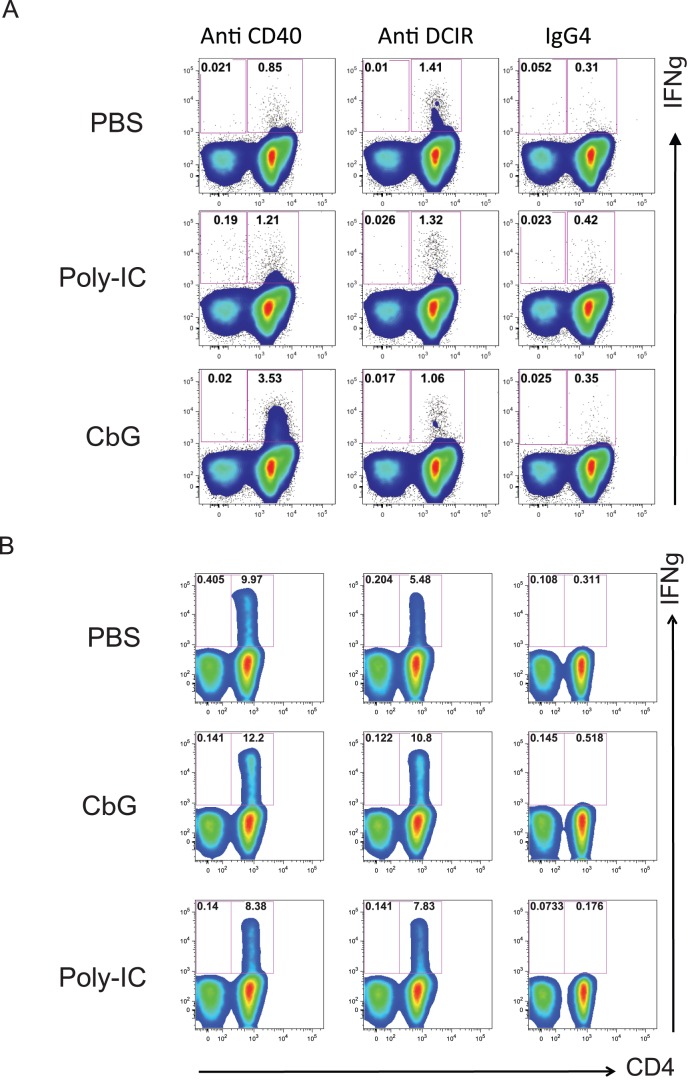

B. melitensis CβG potentiates CD4+ T memory responses in HCV and TB patients.(A) CβG induces CD3+CD4+IFNγ+ T cells after anti-CD40 HCV-NS3HelB DC-targeting of PBMC in HCV cured patients. HCV antigens from NS3 Helicase HelB construct were delivered to IFNα DC through anti-CD40 or DCIR-Ig4 humanized recombinant antibodies. IFNα DC were targeted with anti-CD40-NS3HelB (5 nM), anti-DCIR-NS3HelB (5 nM) or Ig4 control antibody (5 nM) in the presence of Poly I:C (25 µg/ml) or CβG (10 µg/ml) before co-culture for 10 days with PBMC from chronic HCV-infected patients cured after IFNα-Ribavarin therapy. Cells were stimulated for 6 h with peptide clusters (10 µM; 10 peptides of 15-mers) covering HCV NS3 HelB constructs. PBMC were stained for measuring the frequency of peptide-specific CD3+CD4+IFNγ+ T cells and analyzed by flow cytometry. (B) CβG increases CD4+T cell memory responses induced by anti-CD40 or anti-DCIR coupled to Ag85BD41-ESAT6-Rv1980D24 antigens in PBMC from TB patients. IFNα DC were loaded on with IgG4 humanized recombinant mAb Ag85BD41-ESAT6-Rv1980D24 (1 pM) either in the presence of medium versus Poly I:C (2.5 µg/ml) or CβG (1 µg/ml). After 10 days of co-culture with PBMC from acute TB patients, cells were re-stimulated with peptides at 2.5 µM covering the entire ESAT6 protein (22 peptides of 15–16 mers) for 6 h and the magnitude of the immune recall response in terms of the percentage of CD3+CD4+IFNγ+ T cells was analyzed by flow cytometry.